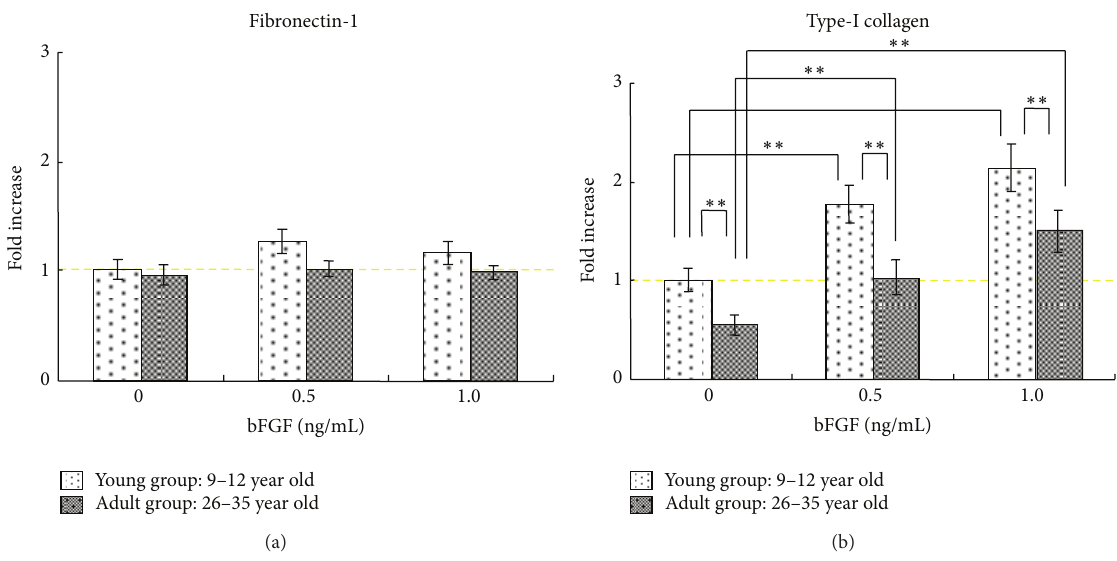
Figure 2: Changes in the gene expression of fibronectin-1 and type-I collagen during differentiation in cultured GFs. Total RNA was extracted from GFs as the cells became confluent; GFs were incubated with bFGF of 0.5 or 1.0ng/mL for 24hrs. The mRNA expression levels of fibronectin-1 (a) and type-I collagen (b) were determined by means of a real-time PCR analysis, normalized relative to the expression of GAPDH, and depicted as the rate of change in gene expression. Error bars indicate a standard deviation. 𝑁 = 8 , ∗ 𝑃 < 0.05 , ∗∗ 𝑃 < 0.01 .